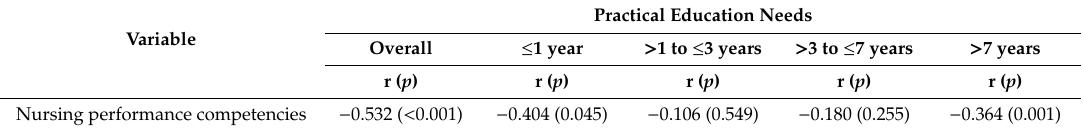
Table 4. Correlation between nursing performance competencies and practical education needs in terms of clinical career ( n =